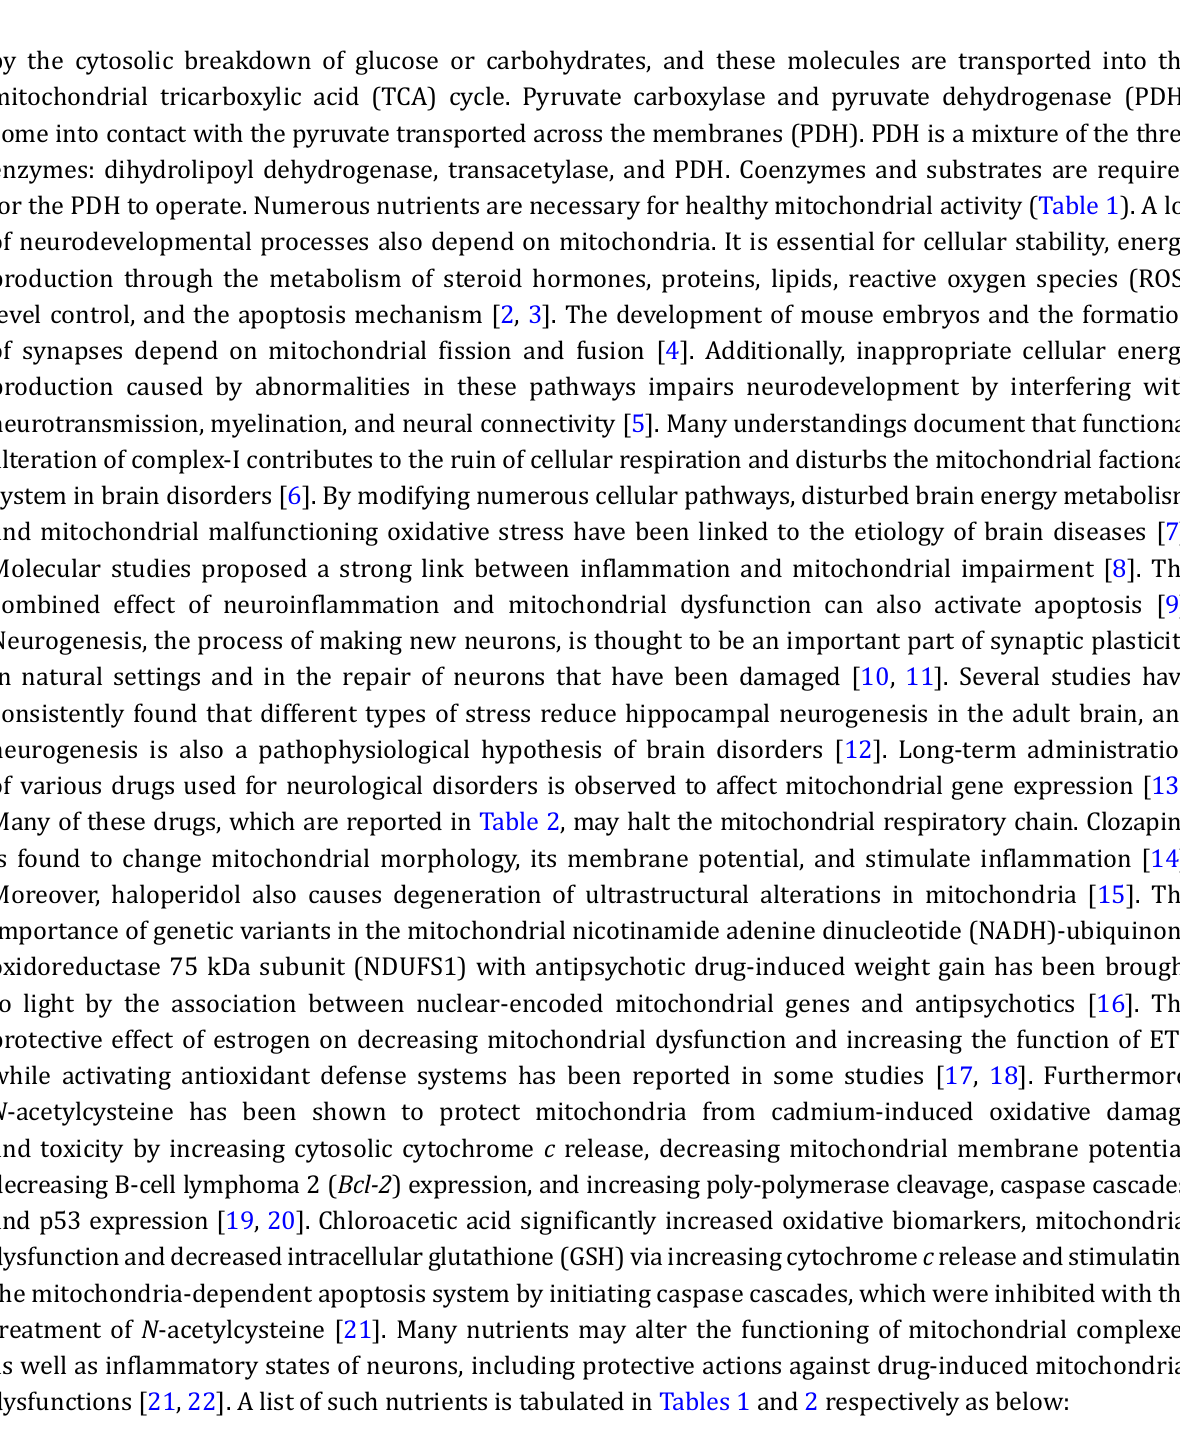
Table 1. Nutrients for mitochondrial complexes function Mitochondrial complex